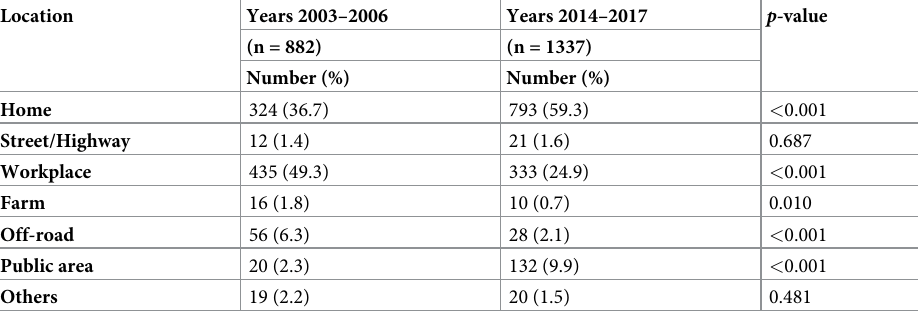
Table 2. Location of injuries during the first (2003–2006) and second period (2014–2017).